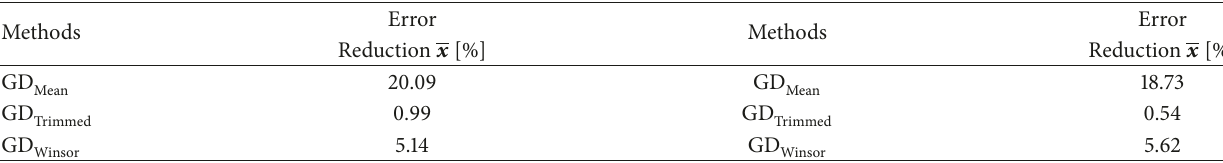
Table 4: Left: case of log normal distribution sampled 20 times and 30 % of Gaussian noise. Right: case of log normal distribution sampled 100 times and 30 % of Gaussian noise. The level of noise is expressed as percentage of the mean of the distributions. The parameters of the log normal are 𝑥 = 2 and 𝑠 = 1 .